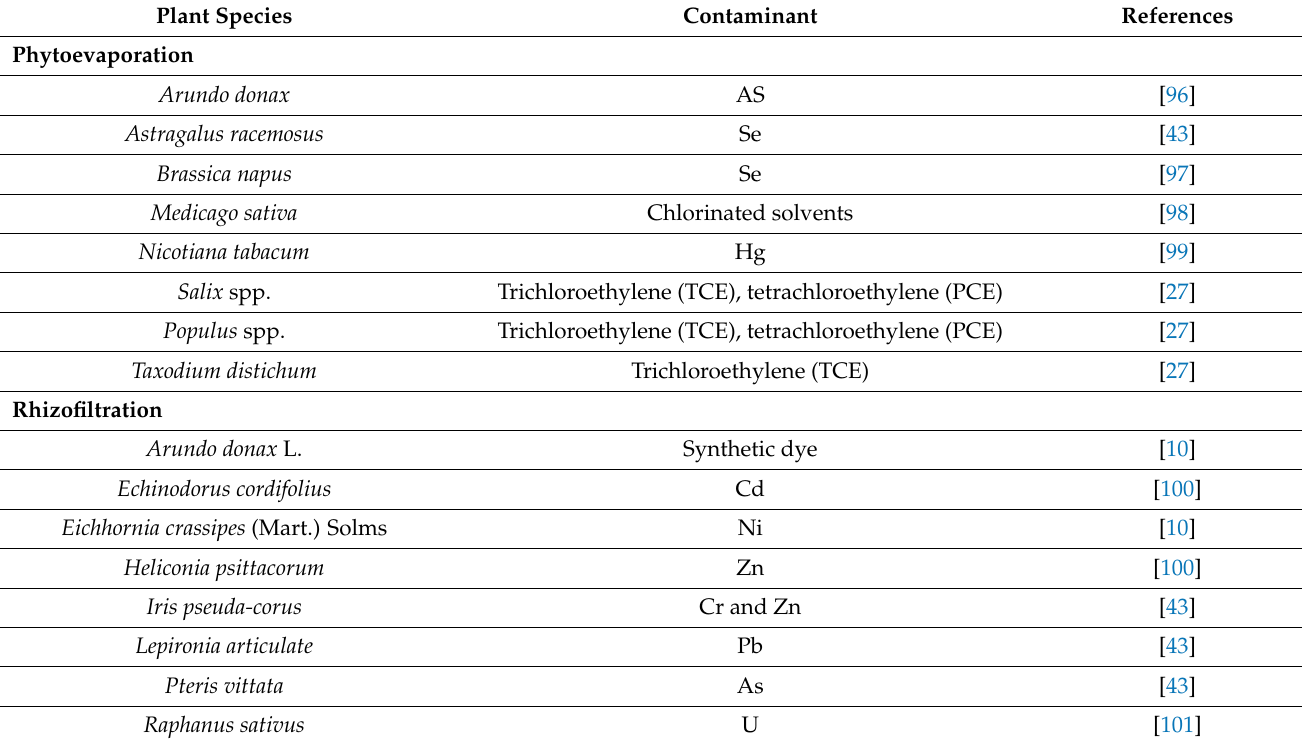
Table 7. Suitable plants for phytoevaporation and rhizofiltration